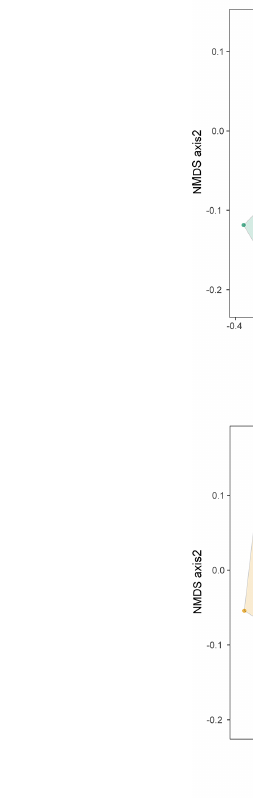
SOIL, 9, 101–116, 2023